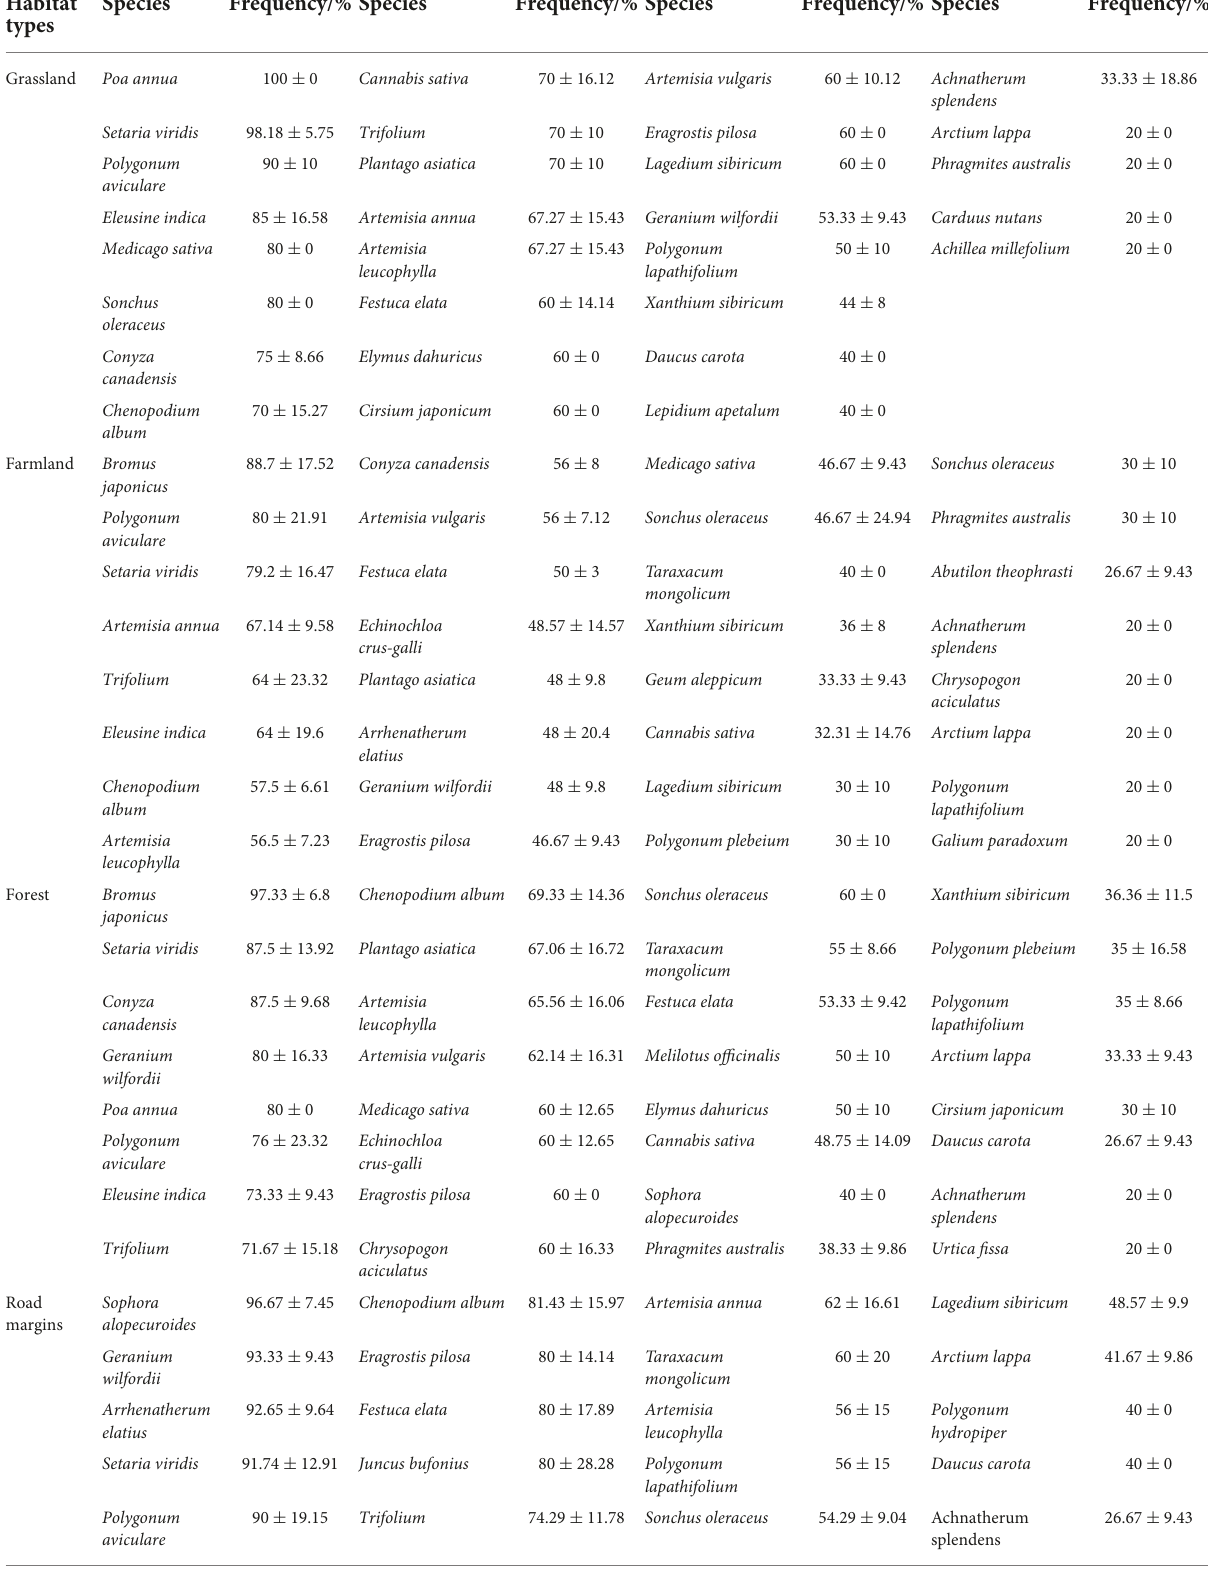
TABLE 1 Distribution frequency (Mean ± SD) of native species in Ambrosia artemisiifolia invasive communities in the Yili Valley. Habitat